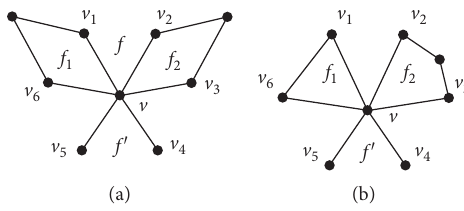
Figure 4: Illustration for the proof of case 2.